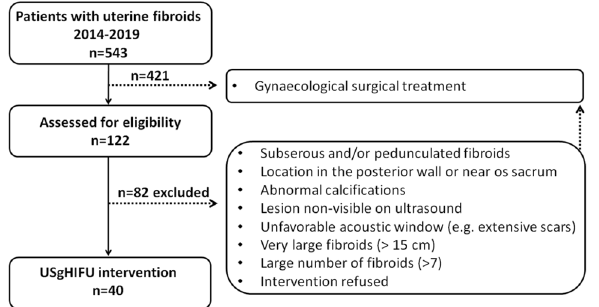
Figure 1. Consort diagram: assessment for eligibility and USgHIFU intervention.